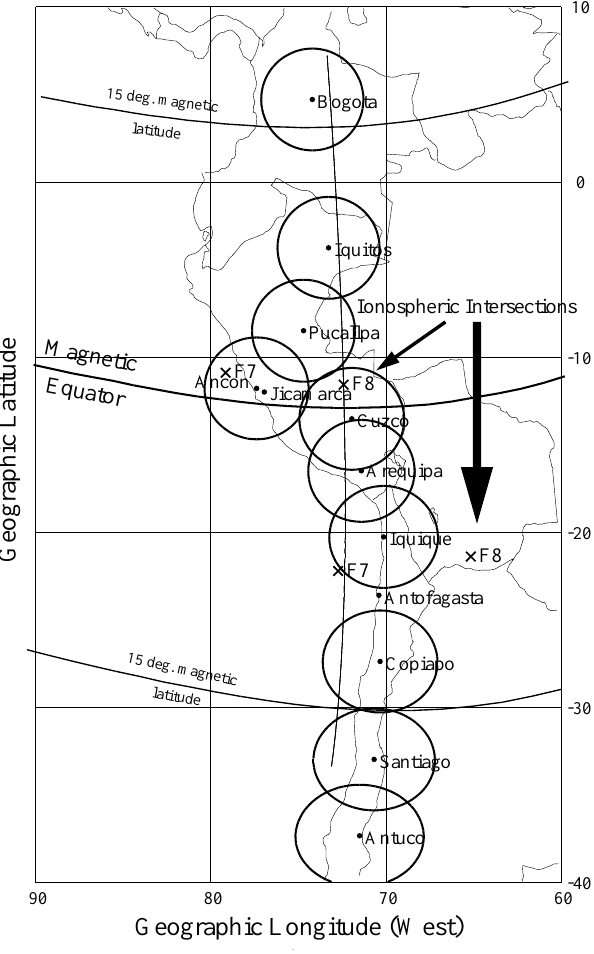
Fig. 1. Geographic locations of several GPS receivers operating near the west coast of South America. The stations at Ancon, Cuzco, Pucallpa, Iquitos and Bogota form the North Andes Project (NAP) network. The stations at Iquique, Copiapo and Antuco are part of the South Andes Project (SAP) network. The stations at Arequipa and Santiago correspond to the IGS network of receivers. The locations of the Jicamarca radar and the sub-ionospheric inter- sections of the lines-of-sight from the Ancon and Antofagasta UHF receivers to the F7 and F8 satellites are also included. The line crossing the F8 intersection point shows the ground projection of a field line with apex height equal to 1200km that ends at 350km